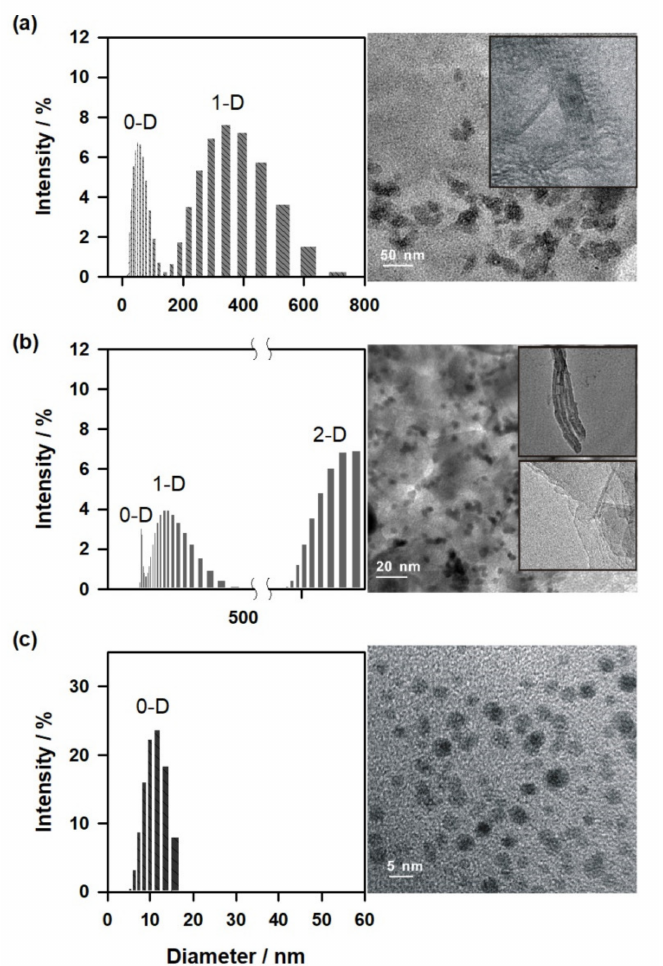
Figure 7. TEM images and size distribution of carbon nanomaterials obtained by the electrochemical exfoliation reaction carried out at an applied potential of 2.0 V versus Ag/AgCl in ( a ) 0.01 M of NaOH, ( b ) 0.1 M of PO 4 3 − , and ( c ) 0.01 M of NaOH + 0.1 M of PO 4 3 − solutions at a fixed temperature of 40 ◦